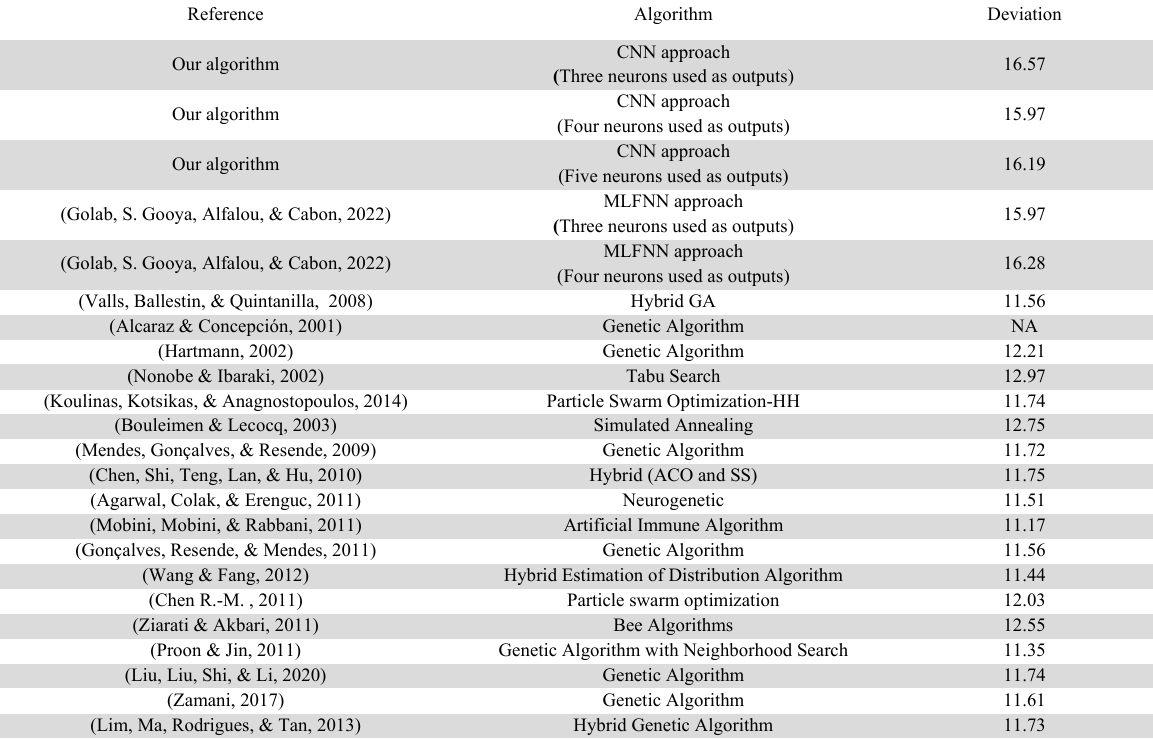
The percentage of average deviations from critical path lower bound for the J60 obtained by our algorithm represents that they are not the best but can be